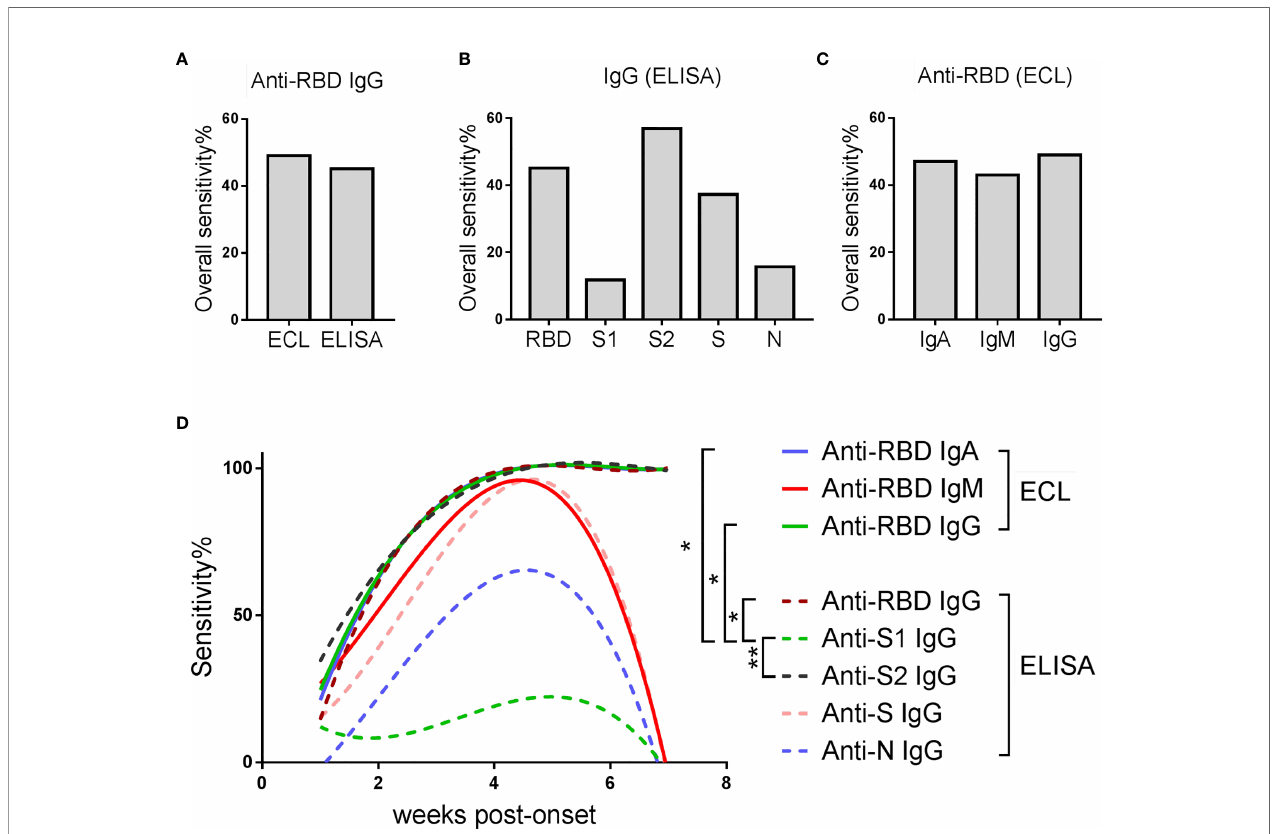
FIGURE 4 | Comparison of sensitivity of various detection schemes in identifying AP. (A) Overall sensitivity of anti-RBD-IgG detected by different methods in all samples. (B) Overall sensitivity of IgG against different SARS-CoV-2 proteins detected by ELISA assay. (C) Overall sensitivity of different antibody isotypes against SARS-CoV-2-RBD detected by ECL assay. (A – C) Overall sensitivity = 100% × (the number of antibody positive samples/the number of all samples). (D) Sensitivity of various detection schemes over time. The line is a trend line fi tted using the nonlinear regression method. Sensitivity = 100% × (the number of antibody positive samples at each time point/the number of total samples at each time point). Friedman test with Dunn's multiple comparisons test was used. A p-value of ≤ 0.05 was considered statistically signi fi cant (*p-values of ≤ 0.05; **p-values of ≤